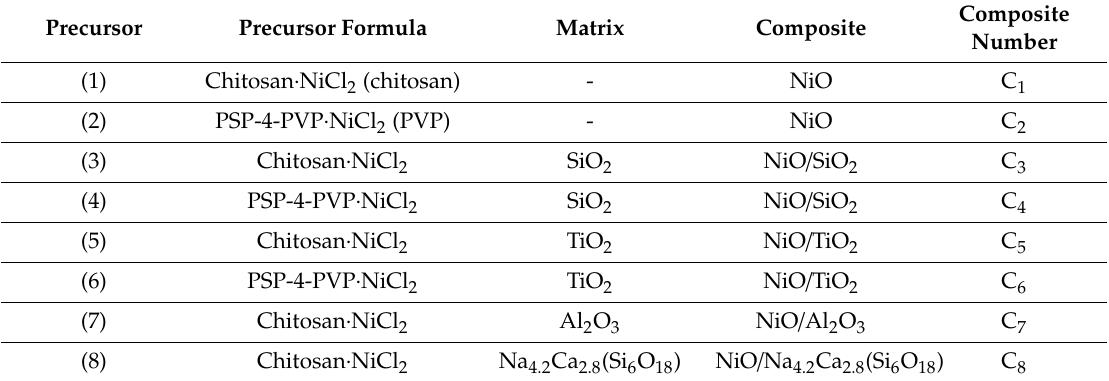
Table 1. Composition of the pyrolytic products from the respective